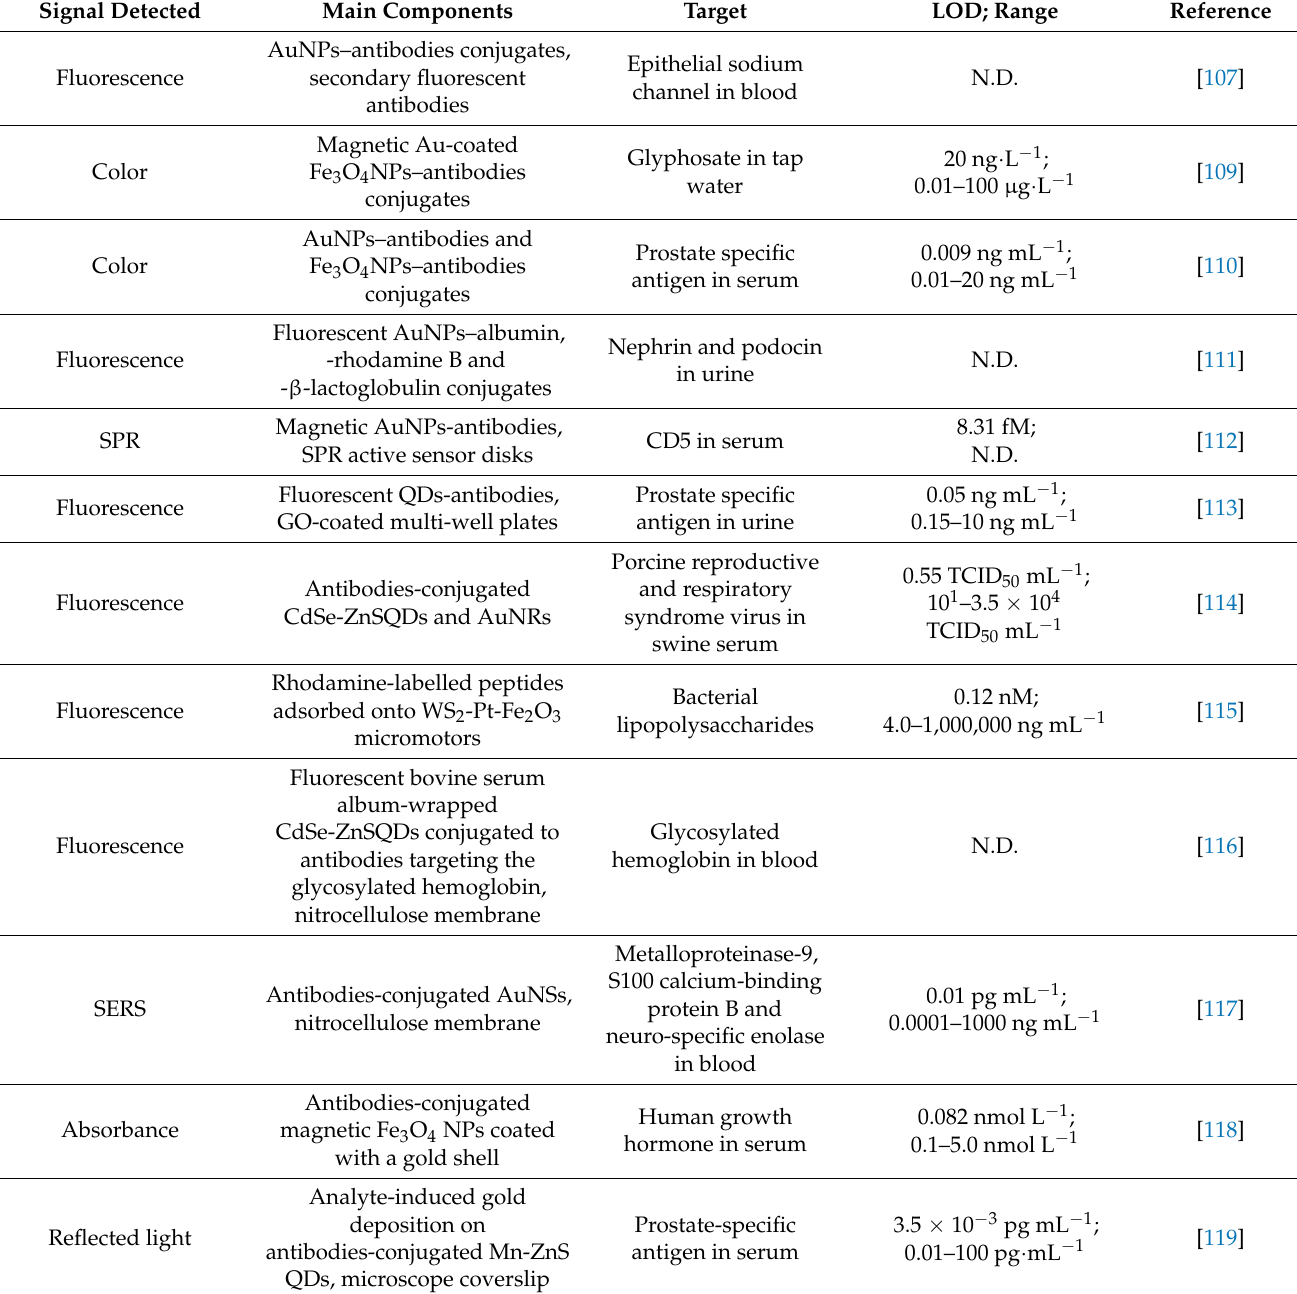
Table 4. Optical immunosensors cited in this